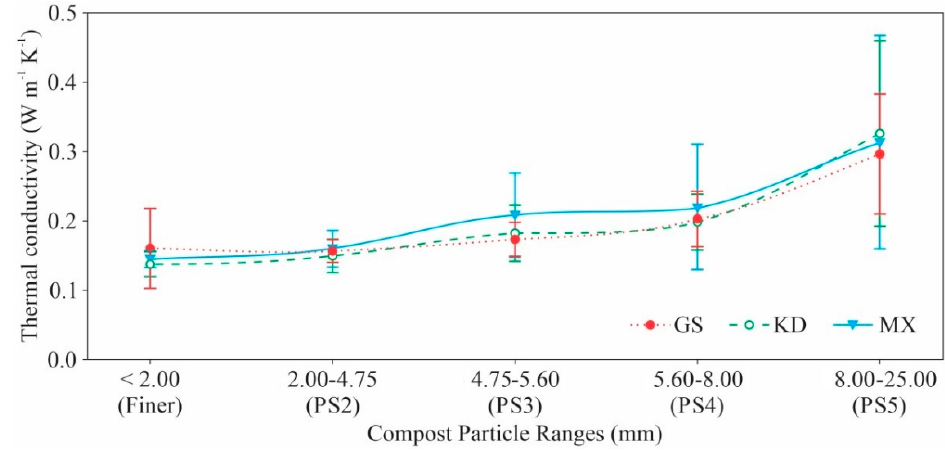
Figure 8. Variation in thermal conductivity (W m − 1 K − 1 ) with different compost particle sizes of compost materials: Green sawdust, Kiln-dried shavings or sawdust, and Mix.